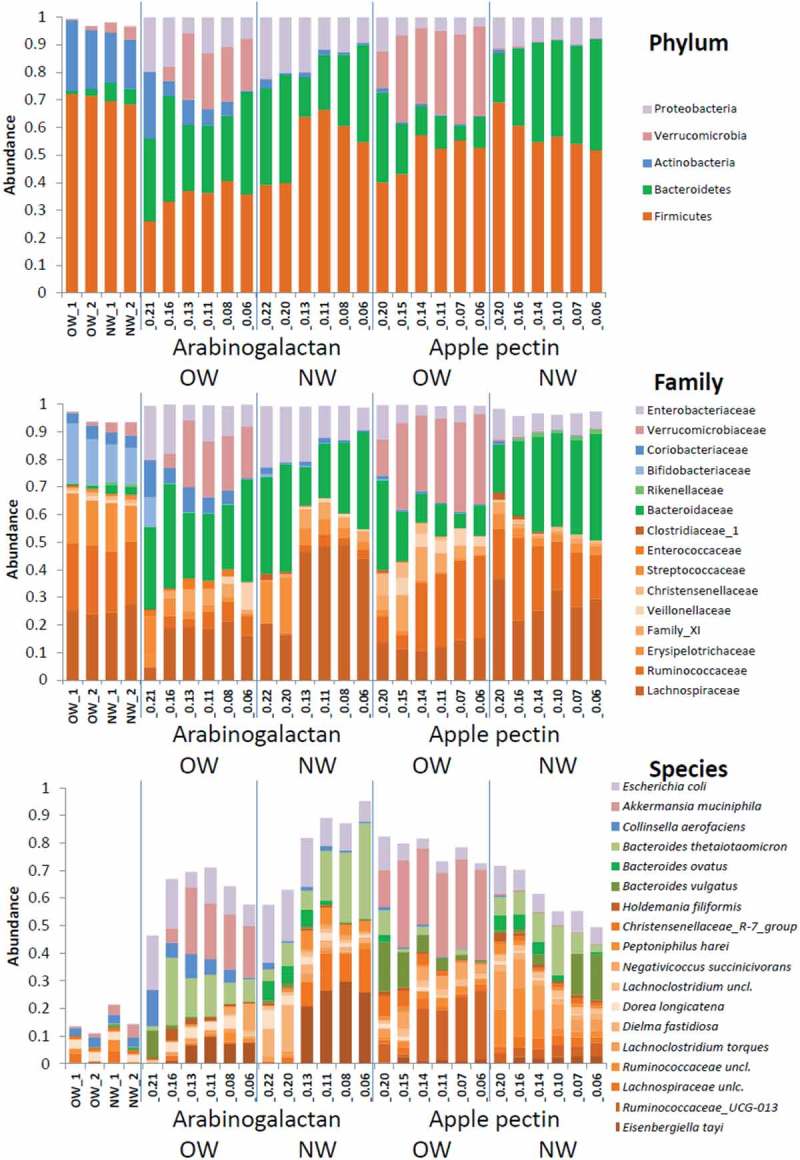
Composition of fecal microbiota in pooled inocula of the overweight (OW) and normal weight (NW) children, and during the De-stat cultivation on arabinogalactan and apple pectin in mucin-supplemented medium on three taxonomic levels. Values at the x-axes designate the dilution rates of the sampling points. Only taxa having average abundance more than 1% are shown in the graphs.